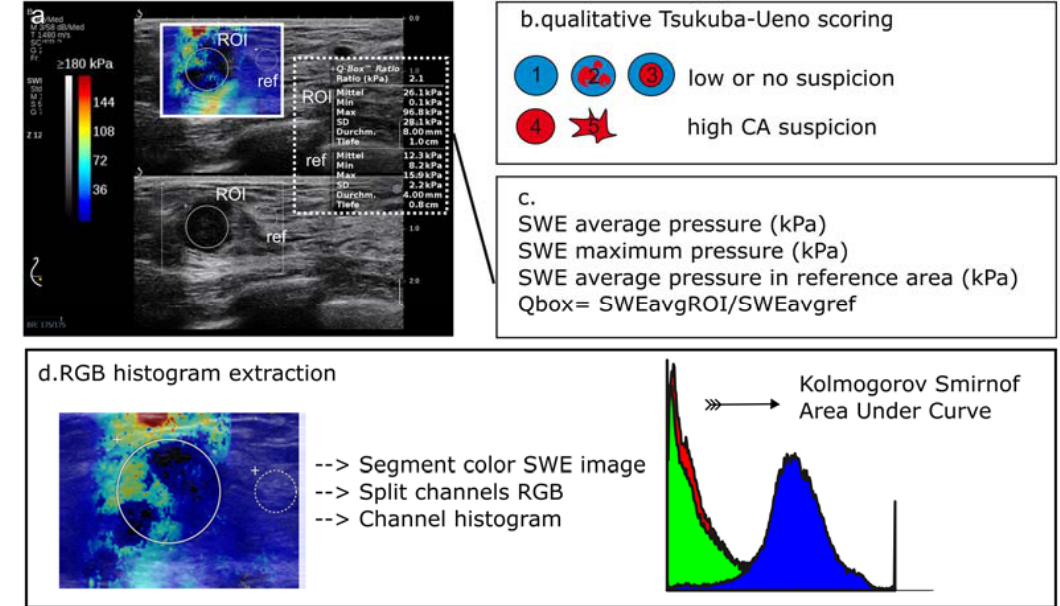
Figure 2. Workflow for image processing. ( a ) Sample image, SWE projected in dual mode with the B-mode parallel imaging. A region of interest (ROI) and a reference region (ref) are defined using the B-mode image to encase the primary lesion (ROI) and a representative reference sample of the surrounding fat tissue (ref). The color map provides pixel-based information on tissue elasticity, explained by the scale bar on the image’s left side and ROI-based statistics on the right (dotted box). Information on the ROI diameter and depth from the skin surface (depth) is also provided. ( b ) Qualitative lesion assessment based on the Tsukuba scale, increasing score from 1 to 5 reflects the probability for malignancy. ( c ) ROI statistics: average, minimum, maximum, and standard deviation (SD) of tissue elasticity in kPa. The Q-box Ratio TM is the fraction of the average target ROI stiffness to the average stiffness of the reference region. ( d ) Segmentation of the whole SWE field for RGB analysis purposes. Image import, RGB channel splitting were performed in MATLAB as described in Materials and Methods section. Histogram differences were compared using the Kolmogorov– Smirnoff test. The diagnostic accuracy of the histogram area under curve (AUC) was interrogated with receiver operating curve (ROC) analysis. CA, cancer; SWE, shear-wave elastography.